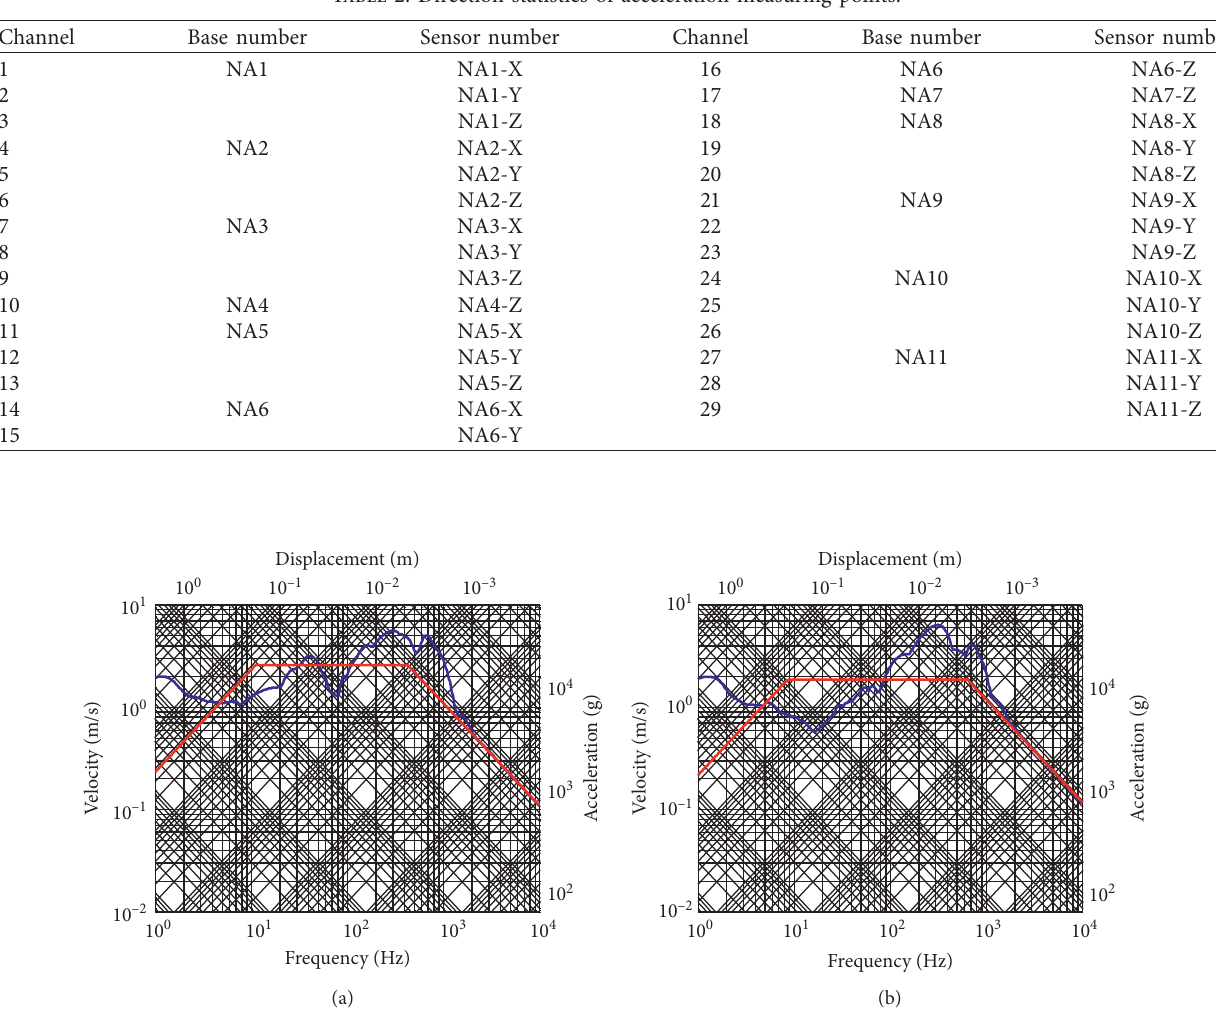
Table 2: Direction statistics of acceleration measuring